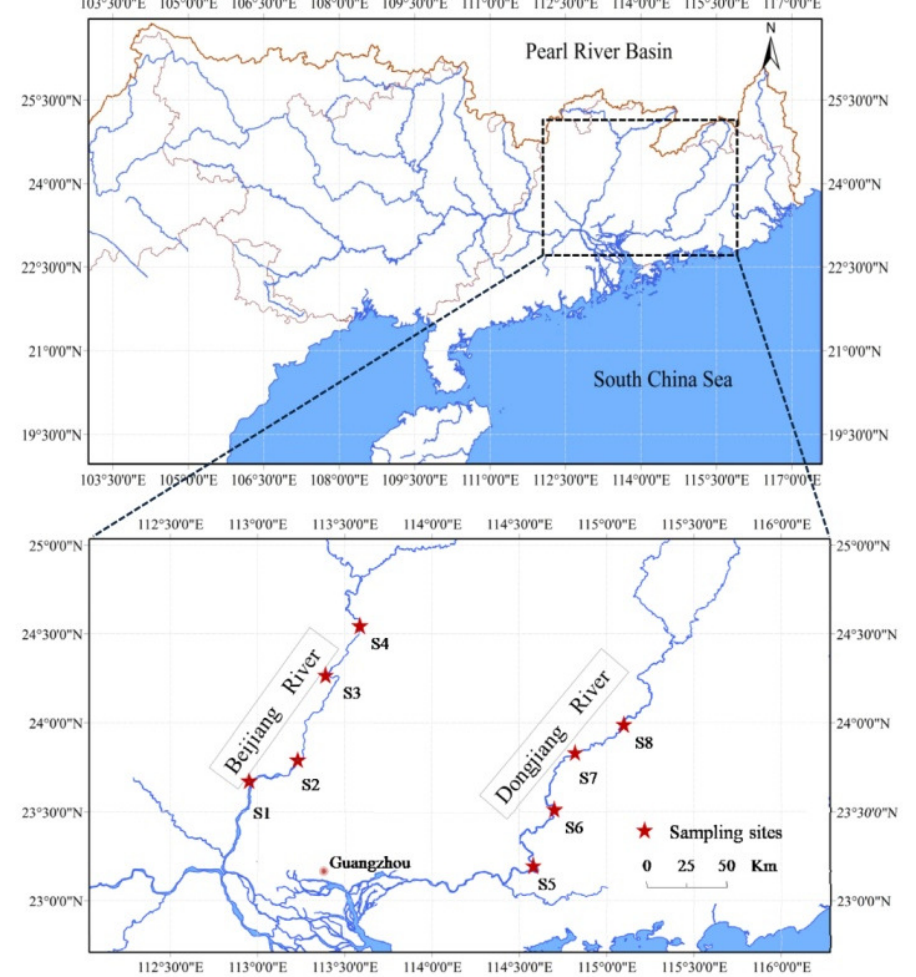
Figure 1. Location of sampling sites. Table 1. Basic information of the sampling sites in the